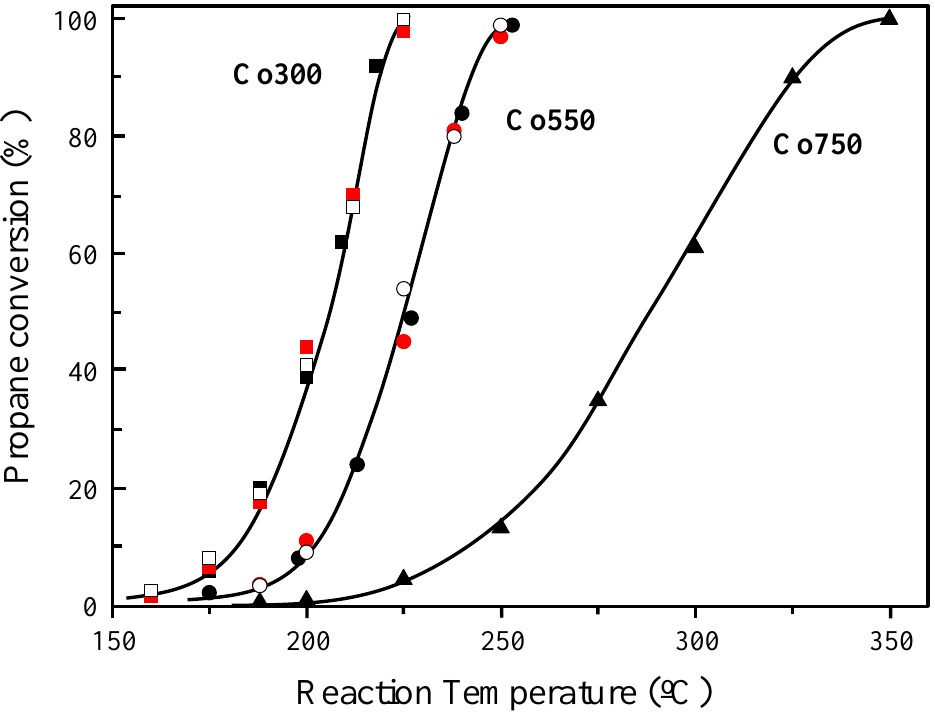
Figure 1. Variations in propane conversion with the reaction temperature in total oxidation of propane for consecutive catalytic cycles over Co 3 O 4 -based catalysts activated at different calcination temperatures: 300 °C (squares), 550 °C (circles), and 750 °C (triangles). First cycle (full black), second cycle (full red), and third cycle (white); reaction conditions detailed in text.